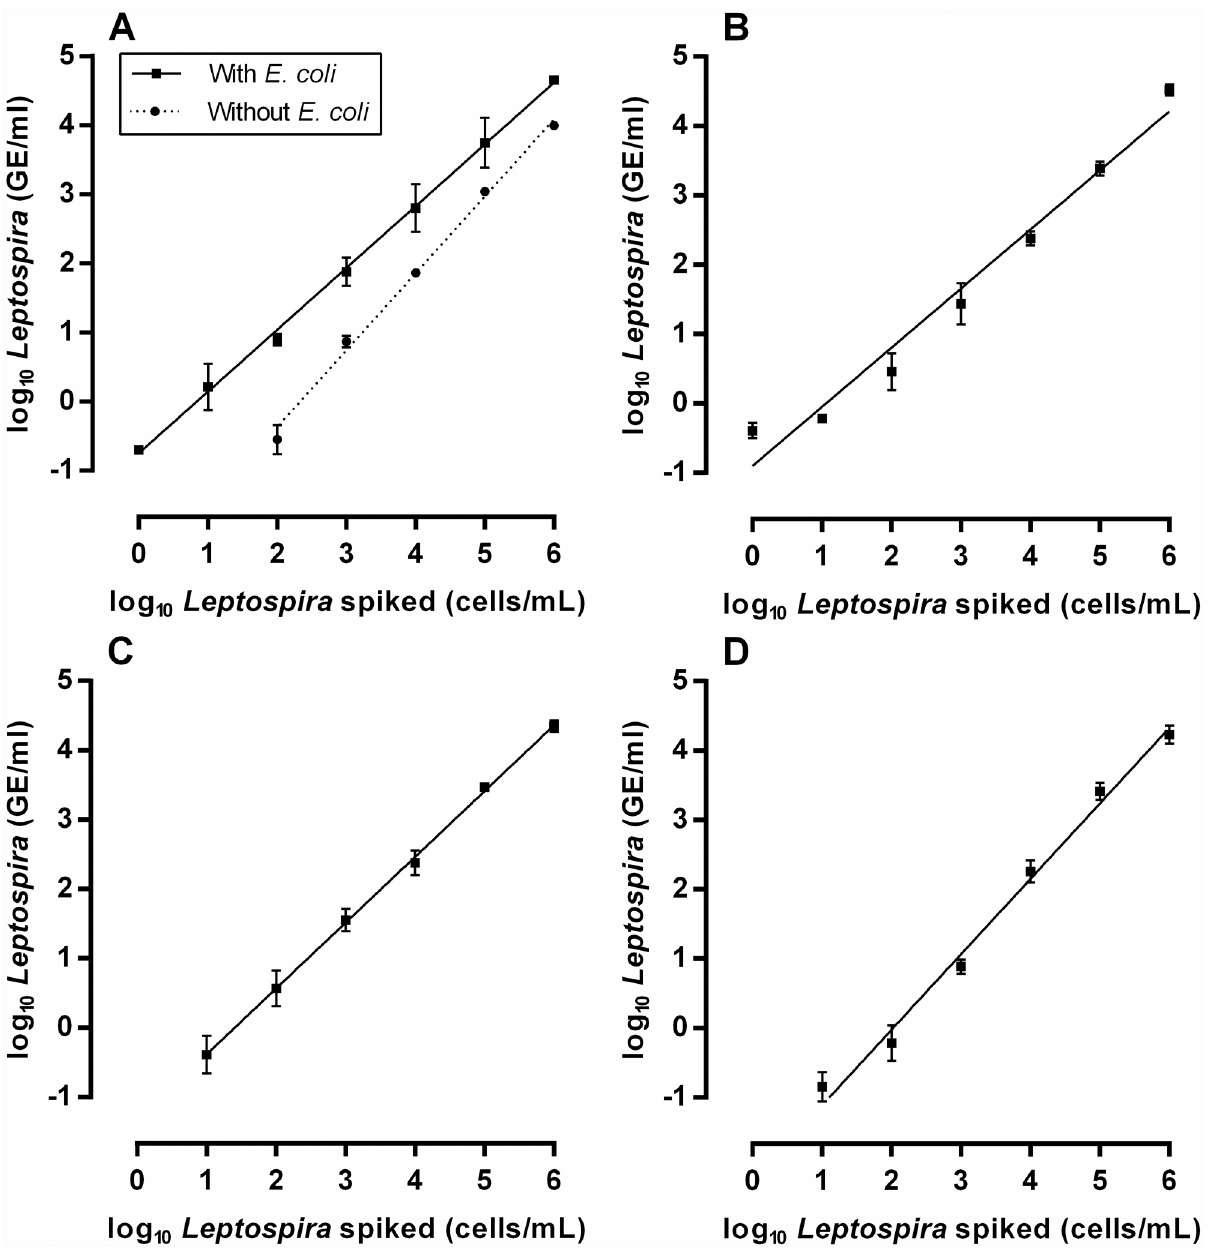
Fig 3. Determination of the lower limit of detection for water samples obtained ultrapure water (A), river (B), pond (C) and sewage (D). Ultrapure water (A) was tested with and without the addition of 1 × 10 7 E . coli /mL. All the samples were spiked with 10 6 Leptospira /mL and 10-fold serially diluted down to 1 Leptospira /mL. Error bars represent the geometric mean ± SD of three independent